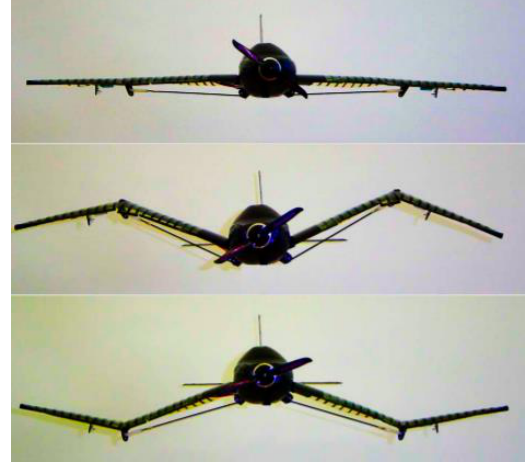
Figure 15. Change in wing structure based on variable gull morphing capabilities [62]